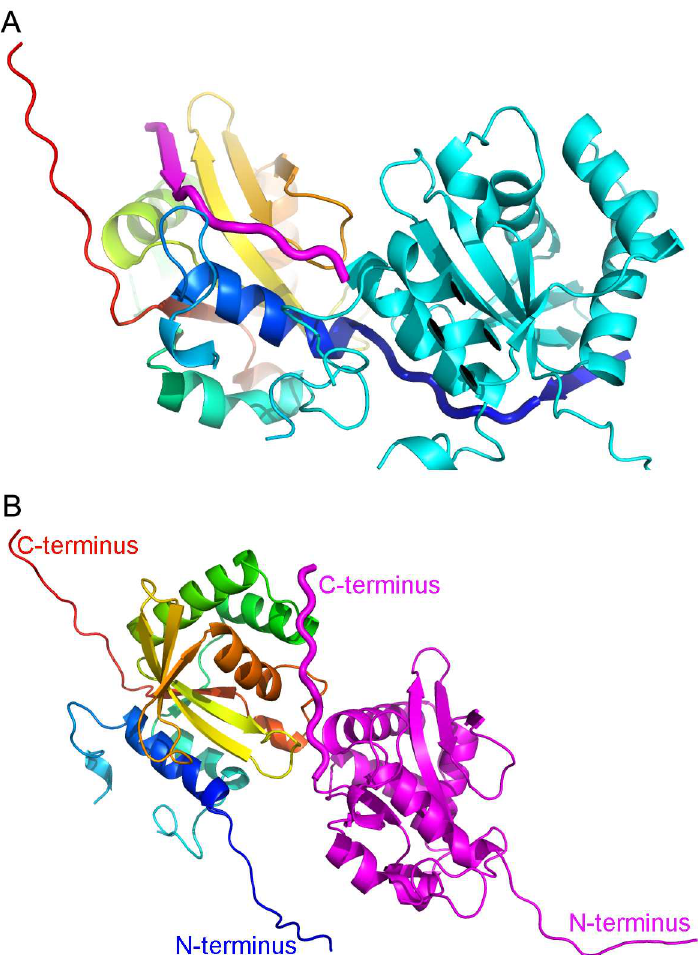
Fig 3. Interactions of the N- and C-terminal segments with neighboring molecules. (A) Segments 17– 32 are swappedbetweentwo moleculesrelated by 2-fold symmetry and are shown as thick ribbonwith residues 23–26 in ß-strand conformation. One moleculeis paintedrainbow, the other is cyan with the N- terminus colored magenta. (B) The extendedC-terminus containing His-tag of magentamoleculecontacts a symmetry-related molecule(rainbowcolored, N-terminus in blue to C-terminus in red). The extendedC- terminus is shown as thick ribbon. These interactions connect moleculesinto a long chain. (C) A model of GtgE reconstructed by re-swapping the N-terminal segment. The residues40–214of moleculeA were connectedto the swappedsegment 17–32 of moleculeB through a short